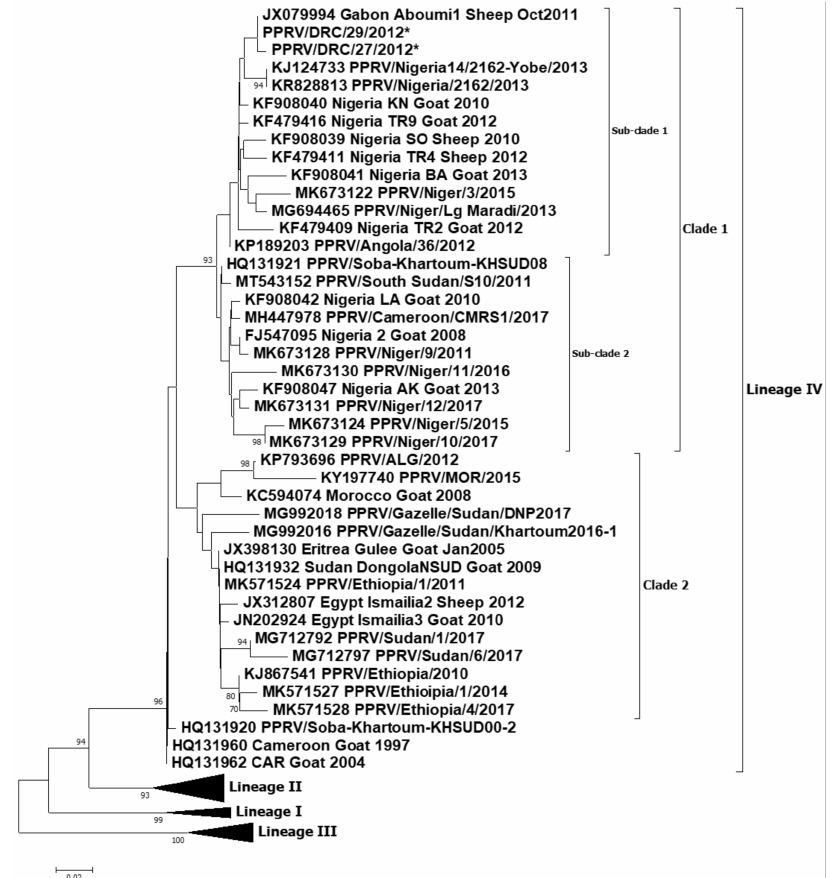
Figure 2. Neighbor-joining tree constructed using partial N gene sequences of peste des pe- tits ruminants virus (PPRV), showing relationships among the PPRV lineage IV isolates circulat- ing in Africa. The Kimura 2-parameter model was used to calculate percentages (indicated by numbers beside branches) of replicate trees in which the associated taxa clustered together in 1000 bootstrap replicates. The sequences from the DRC generated in this study (accession numbers: PPRV/DRC/Tshela/27/2012-OL310685 and PPRV/DRC/Tshela/29/2012-OL310686) are indicated by a star. Scale bar indicates nucleotide substitutions per